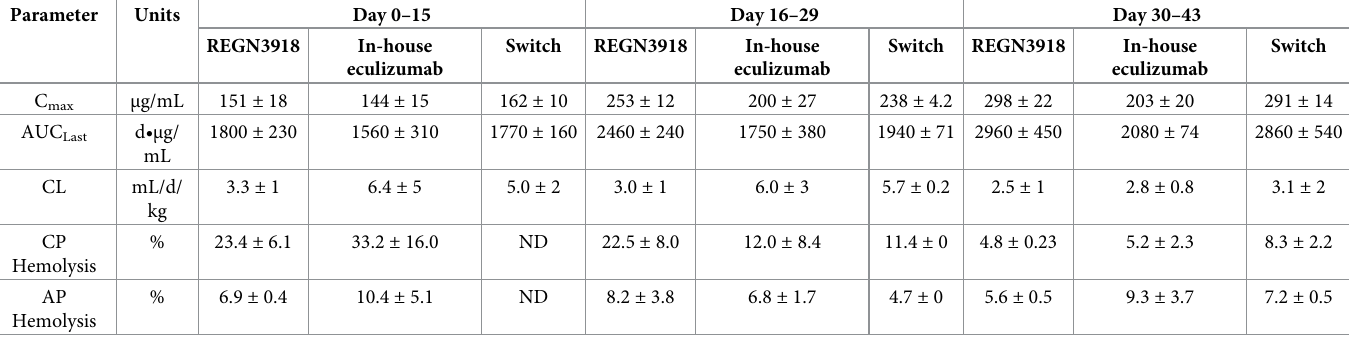
Table 4. PK/PD parameters of antibodies in C5 hu/hu mice dosed with in-house eculizumab alone, REGN3918 alone or switched from in-house eculizumab to REGN3918.